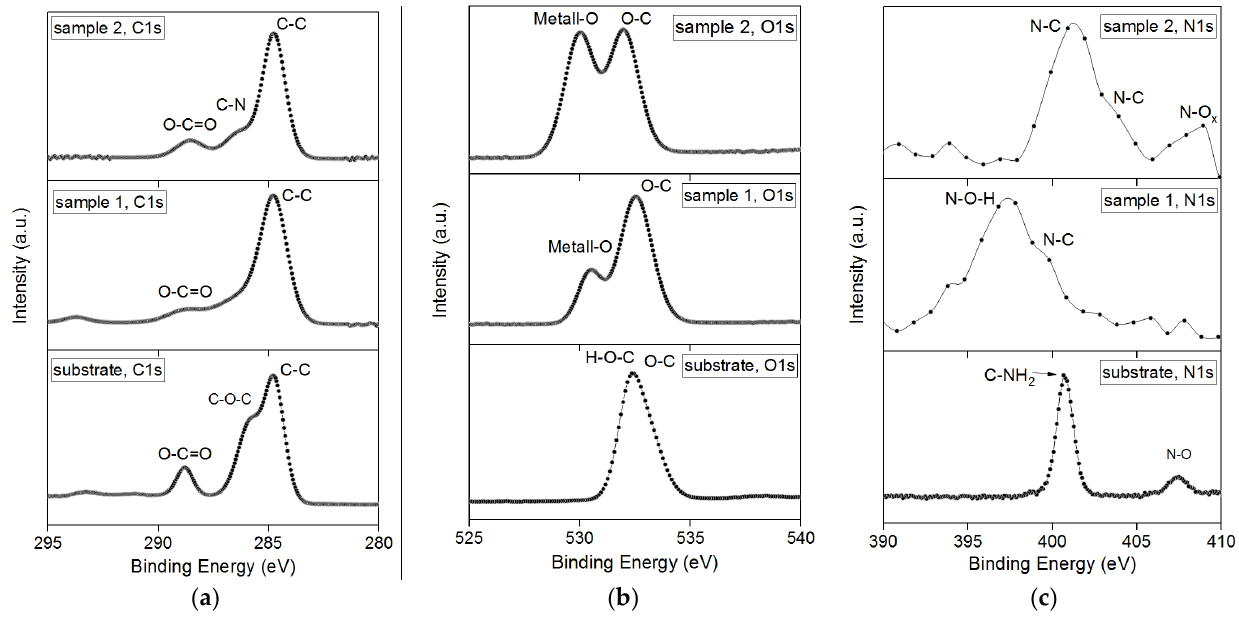
Figure 4. XPS from samples and pure polyimide prior to film deposition: ( a ) XPS from 1s carbon electrons; ( b ) XPS from 1s oxygen electrons; ( c ) XPS from nitrogen 1s electrons.